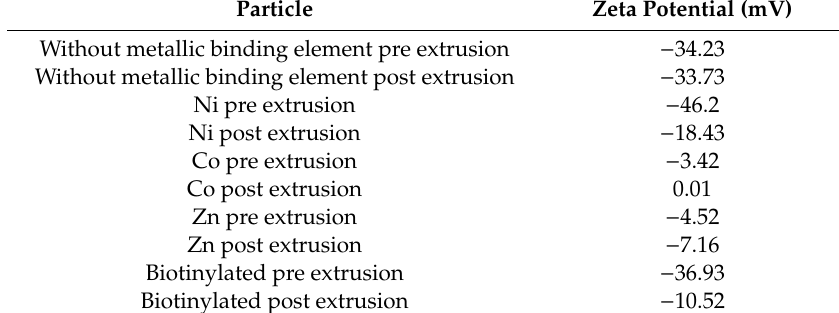
Table 2. Empty liposome surface charge.